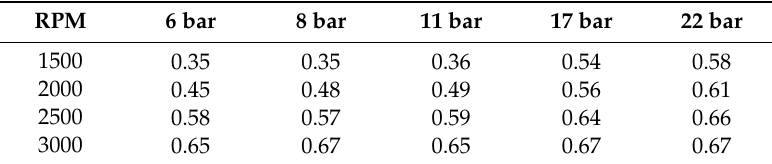
· η Table 3. η m as a function of ICE speed and mean e T